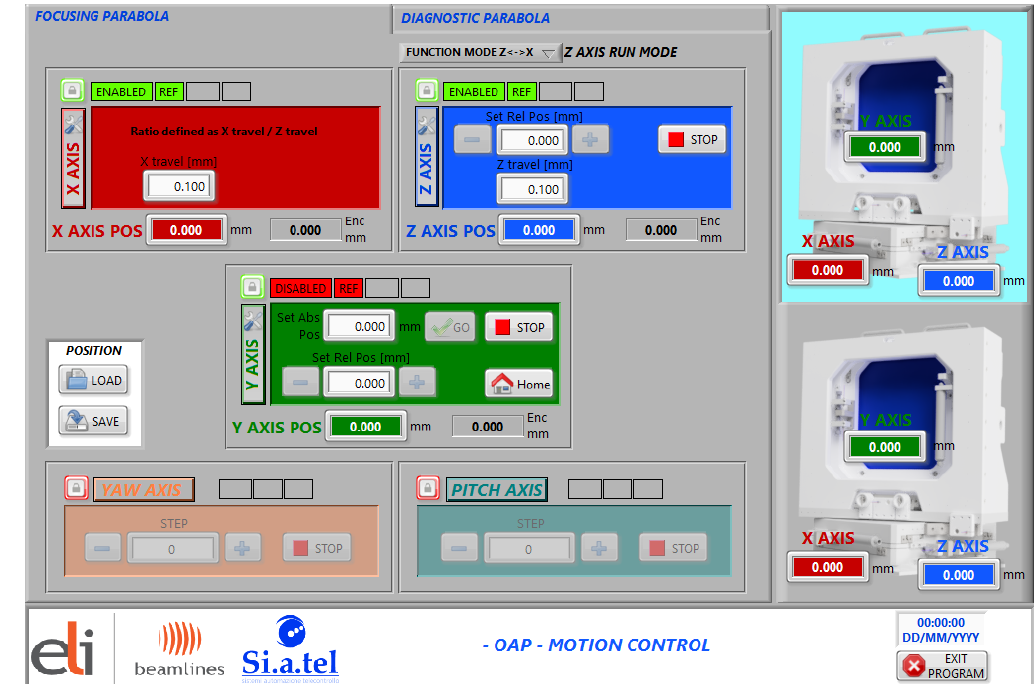
Figure 6. Typical example of focal spot at the ELIMAIA interaction chamber ( A ) and processed image for the calculation of the laser intensity on target ( B ). In this case, the energy at FWHM is 21.1% .